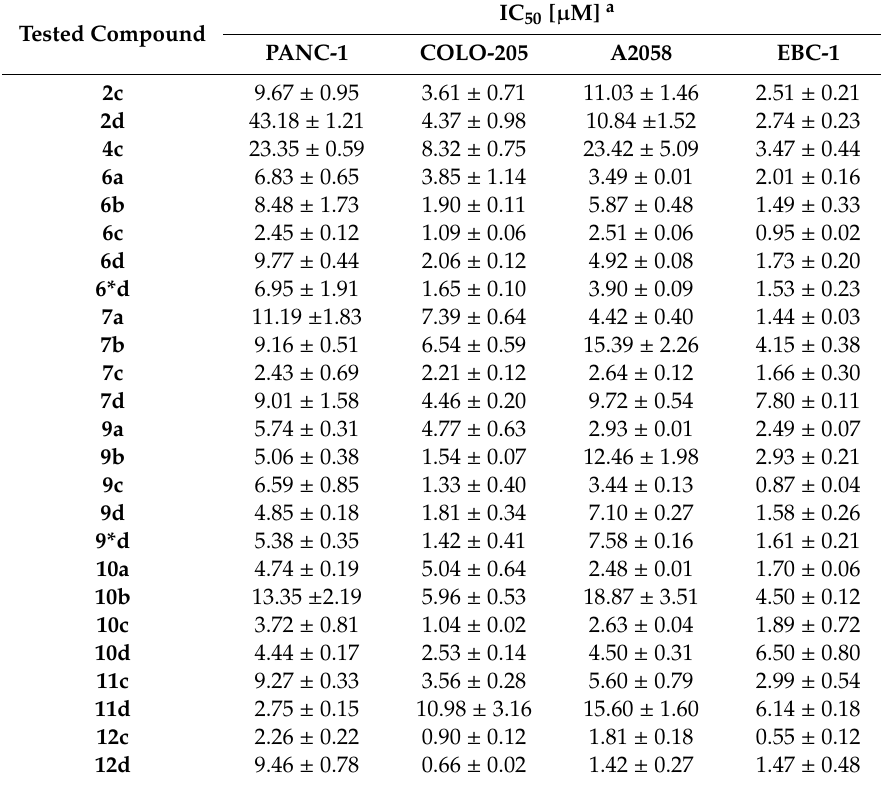
Table 4. Cytotoxic activity of cinchona-chalcone hybrids expressed in IC 50 values on four human tumour cell lines.